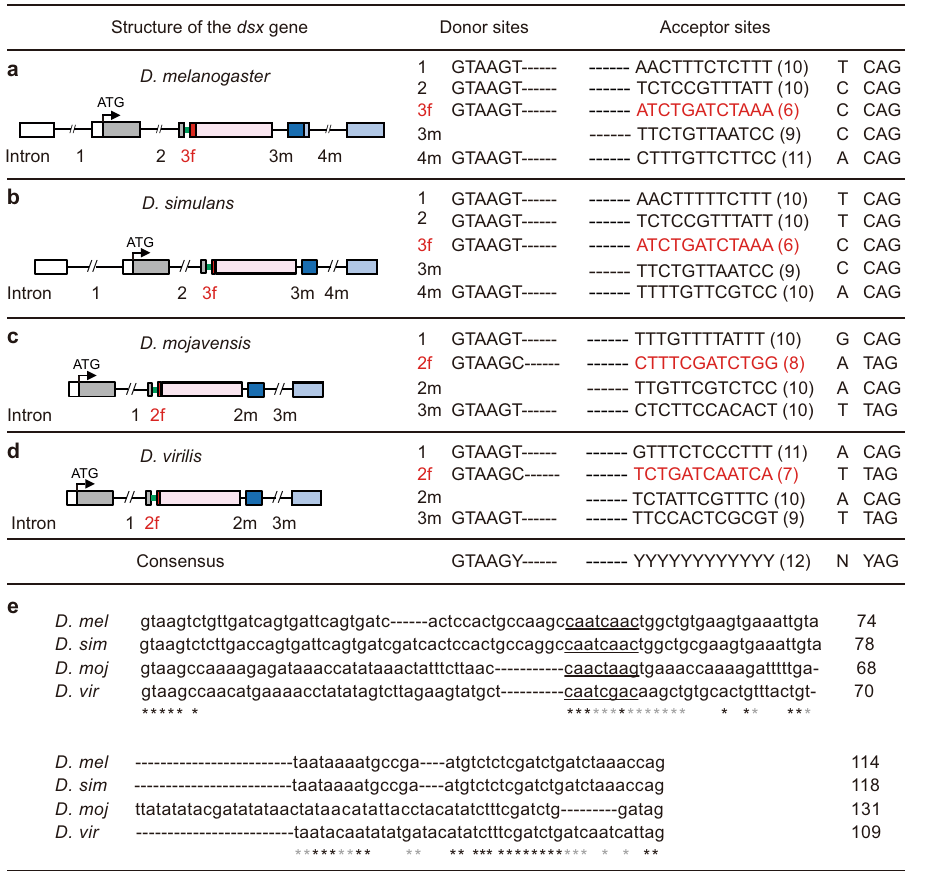
Fig. 4 Retained introns share conserved sequence properties. a – d Comparison of donor and acceptor sequences of spliced and retained introns. The structure of the dsx gene including introns (black lines), the retained intron for dsx M2 (thick green line), and exons (boxes), as well as splicing donor and acceptor sequences for each intron in D. melanogaster ( a ), D. simulans ( b ), D. mojavensis ( c ) and D. virilis ( d ). Introns were labeled with numbers followed by “ f ” (female-speci fi c splicing) or “ m ” (male-speci fi c splicing). respectively. As for the consensus sequences, Y indicates pyrimidine, and N indicates either A, G, T or C. The number of pyrimidines in the 12 upstream nucleotides of the acceptor sequence NYAG is indicated in the brackets for each intron. e Comparison of retained intron sequences of dsx M2 in four Drosophila species. Underlined letters indicate potential Tra binding sites. Black asterisks indicate perfect matches of amino acids among four species, and gray asterisks indicate three matches out of four